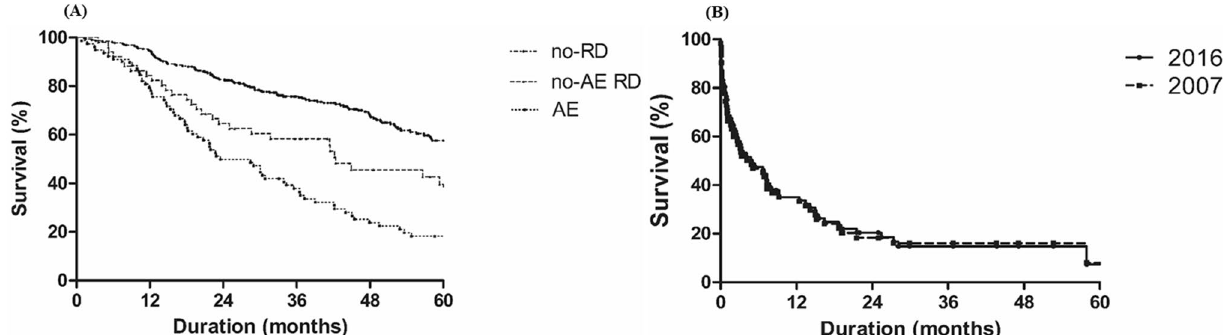
Figure 2. ( A ) Comparison of survival curves from diagnosis of IPF between AE, no-AE RD and no-RD groups among patients with IPF. ( B ) Comparison of survival curves after hospitalization in patients with AE according to 2007 and 2016 definition of AE. AE acute exacerbation, RD respiratory deterioration, IPF idiopathic pulmonary